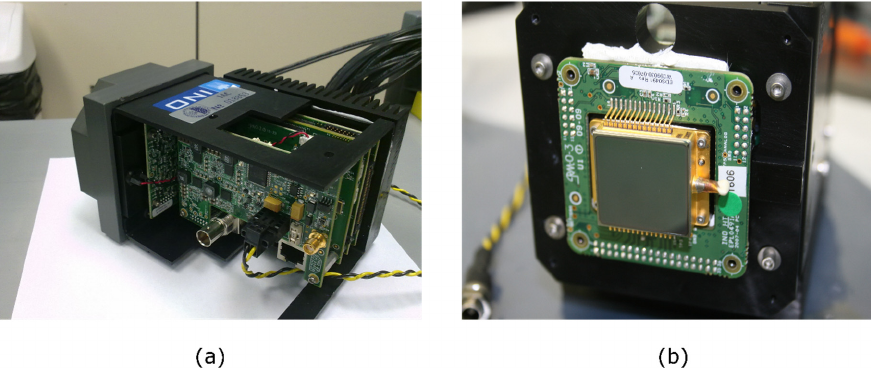
Figure 2. High-end thermal Camera: ( a ) INO IRXCAM-640 housing and electronics; ( b ) Microbolometer (ULIS-04-17-1) mounted on the housing. Table 2. Characteristics of the INO IRXCAM-640 [30].